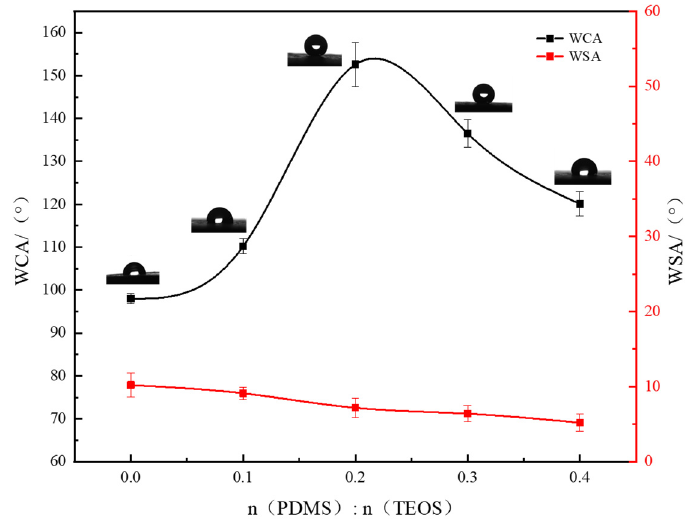
Figure 7. Effect of molar ratio of PDMS and TEOS on the contact angle.